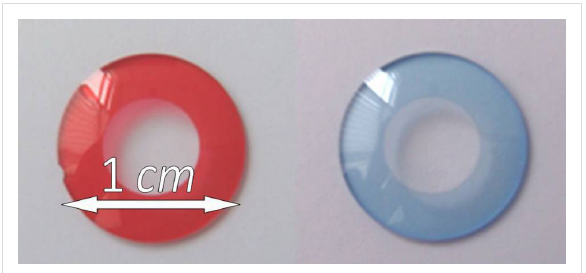
Figure 3: Sharpened blank of polymerized red 9 and blue 10 with HEMA, THFMA and EGDMA (left, right).